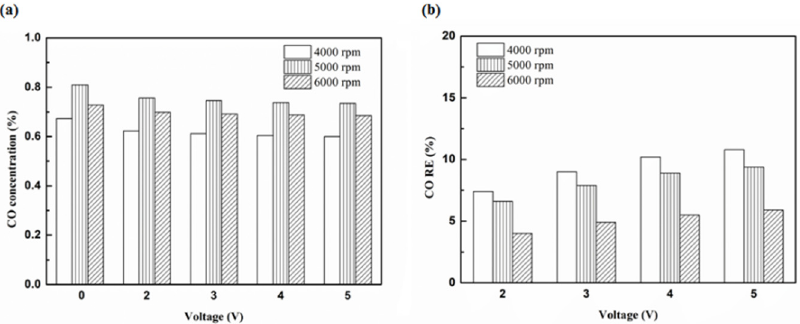
Molecules 2020 , 25 , x FOR PEER REVIEW Figure 13. The CO ( a ) emission values and ( b ) RE using iridium alloy in the front of the exhaust pipe.